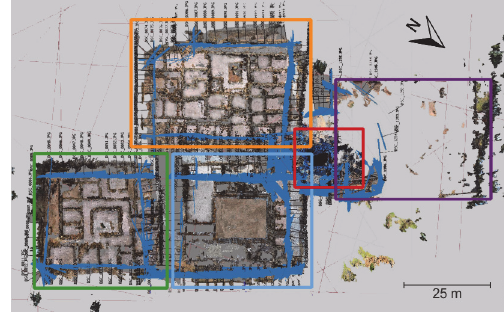
Figure 3. Image clusters employed for the archaeological case.